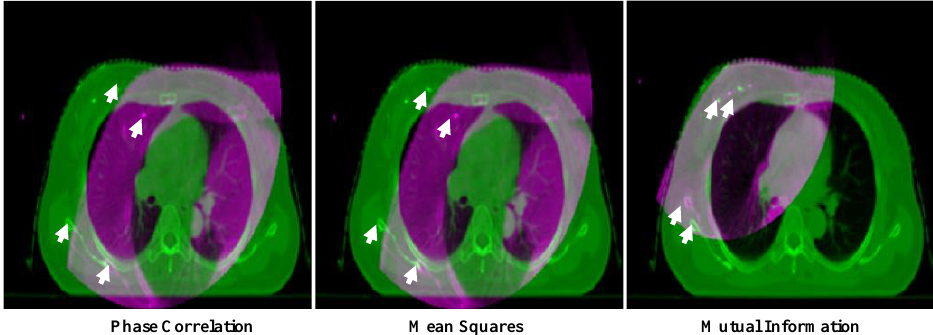
Figure 6. Intensity-based registration result using different similarity metrics.